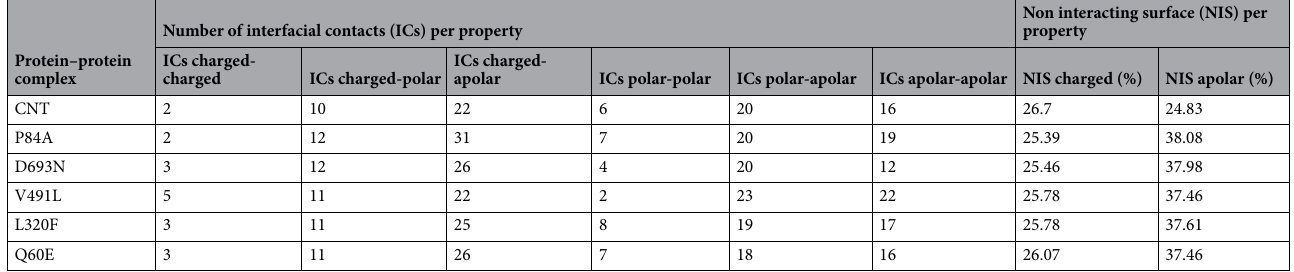
Table 4. Type of interactions affecting the binding affinity (Kd), and stability (ΔG) of docked complexes at 37 ℃ .